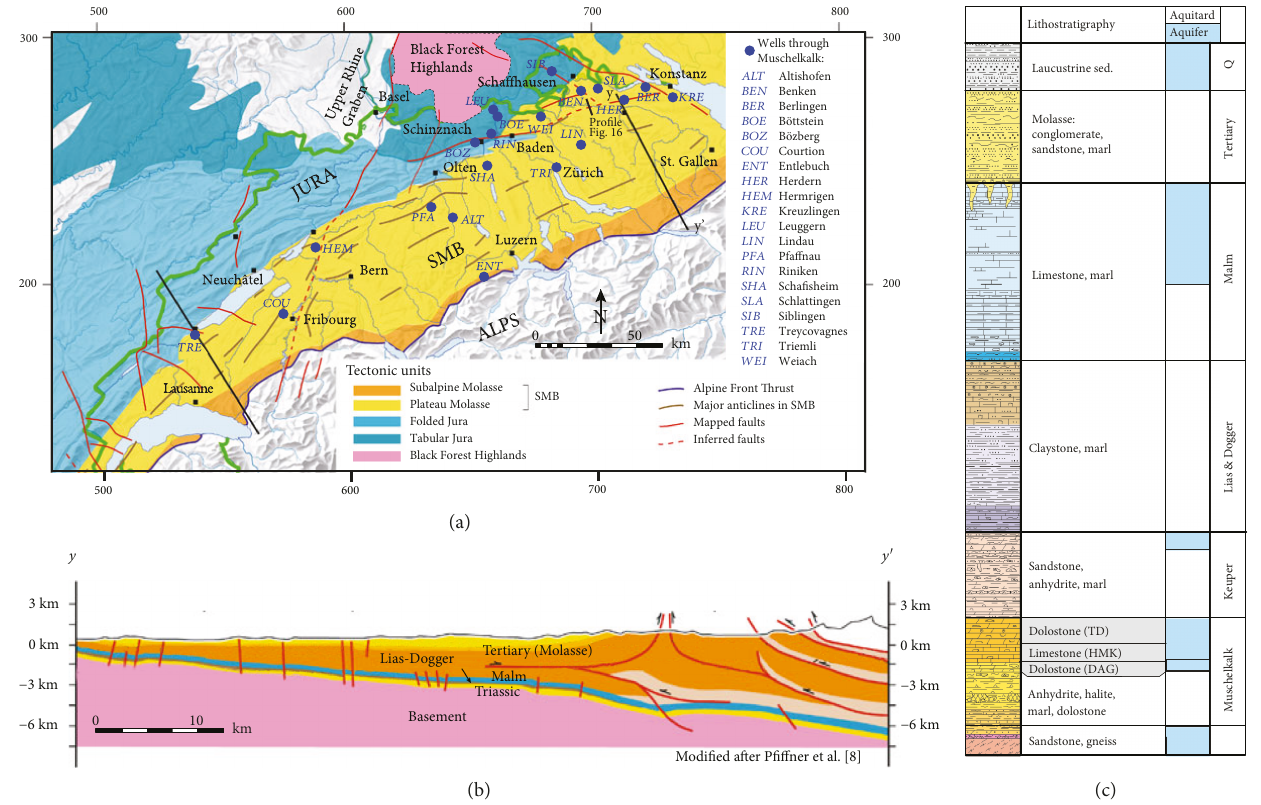
Figure 1: (a) Geology of the Swiss Molasse Basin. The thick green line is the national border. Coordinates are Swiss km grid. (b) Cross section y – y ′ after P fiff ner et al. [8]. (c) Litho- and hydrostratigraphy of the Mesozoic and Cenozoic sediments at the Benken (BEN) well (TD: Trigonodus Dolomit; HMK: Hautpmuschelkalk; DAG: Dolomit der Anhydritgruppe; modi fi ed after Nagra